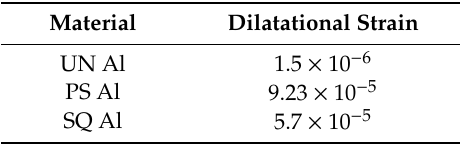
Table 2. Synchrotron XRD measurements of dilatational strain for 3–4.5 µ Al particles